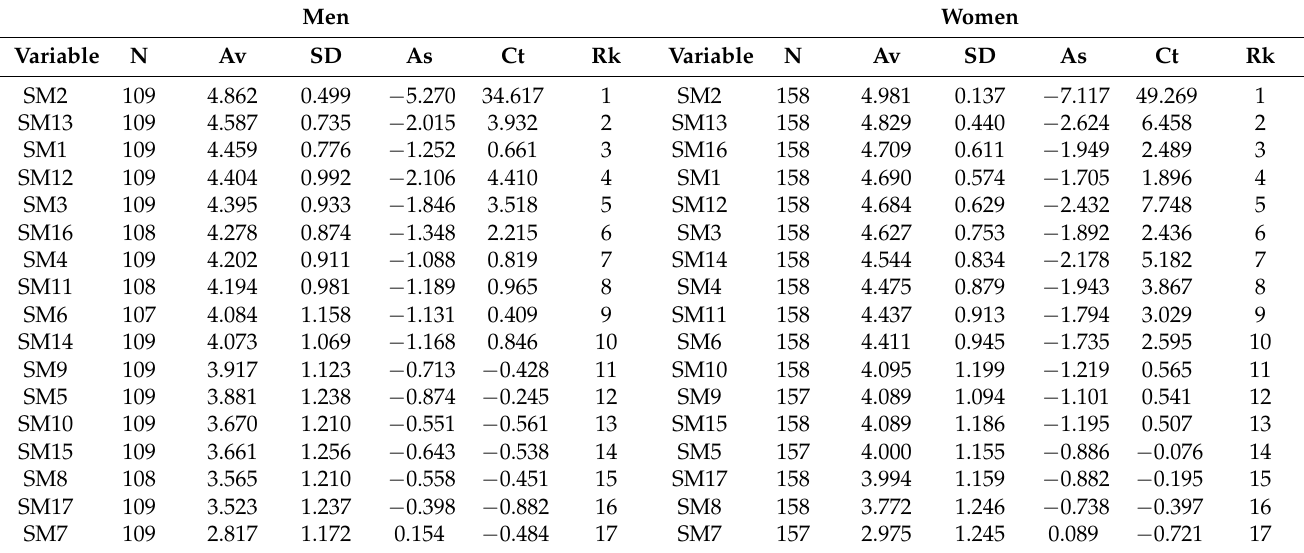
Table 4. Descriptive statistics (Classification of measures by